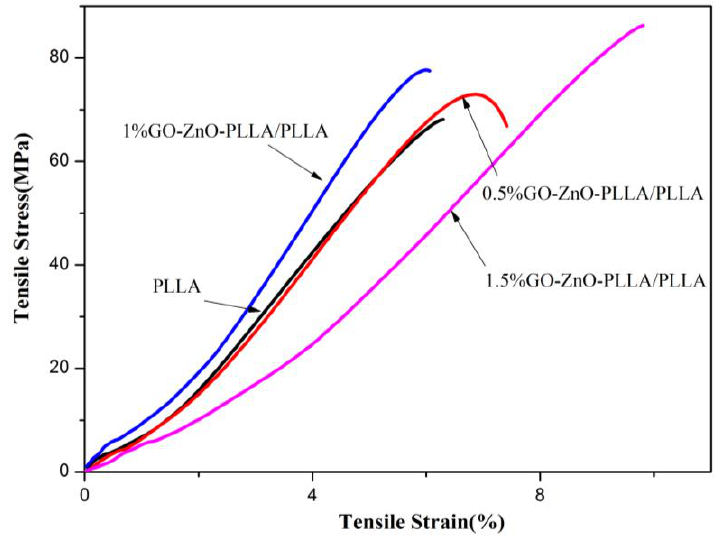
Figure 10. The stress–strain curve of PLLA and GO-ZnO-PLLA/PLLA composite films. Table 2. Test of tensile properties of PLLA and GO-ZnO-PLLA/PLLA.